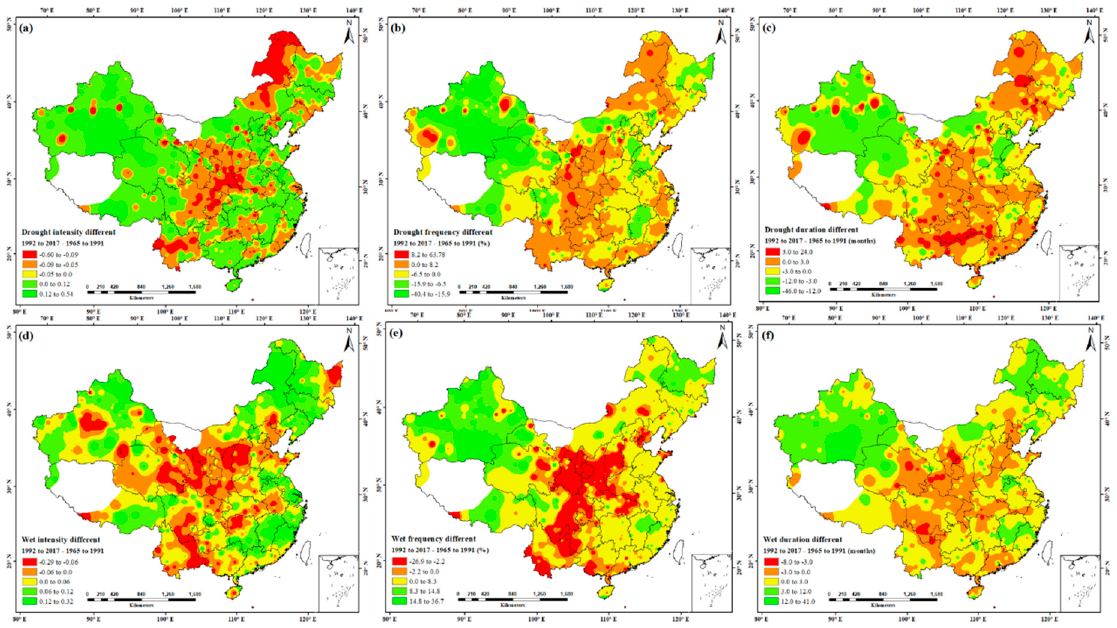
Figure 11. Spatial pattern of the difference in drought and wetness intensity ( a , d ), frequency ( b , e ), and duration ( c , f ) between two periods: 1992–2017 minus 1965–1991.